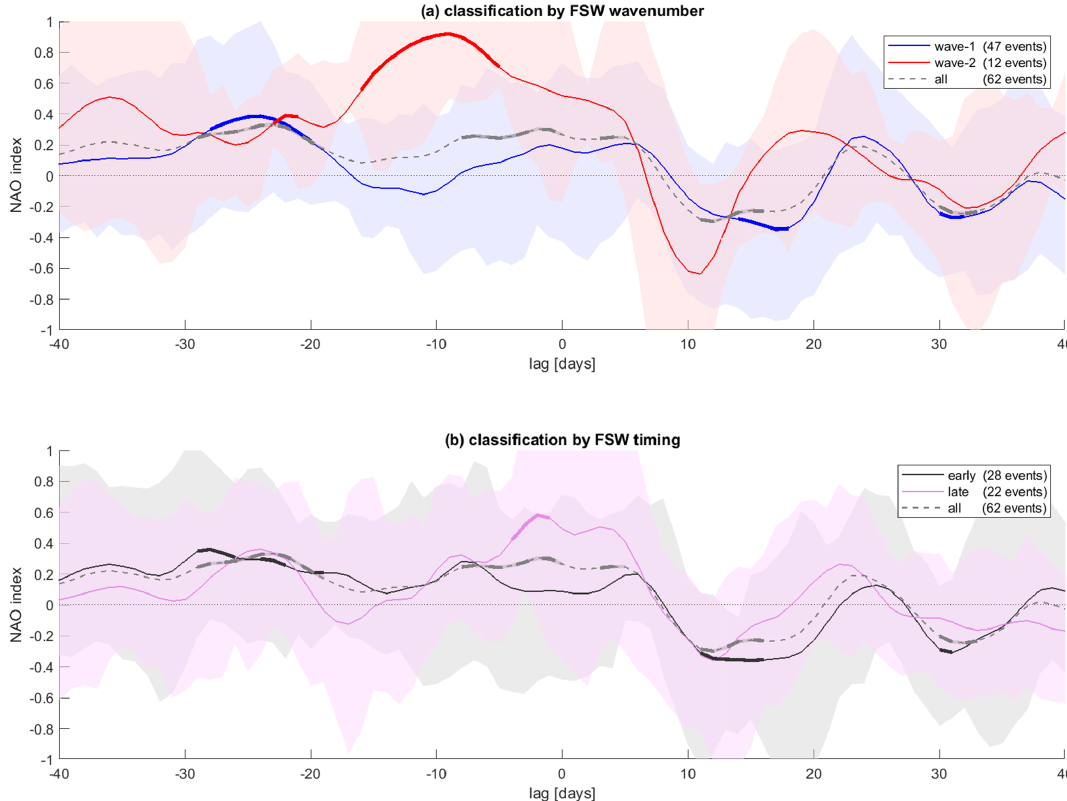
Figure 9. Composite of the NAO index (using a 3d running mean) for lags of − 40 to + 40d around the final warming dates at 50hPa for 1958–2019. (a) The blue (red) lines indicate the average values for the wave-1 (wave-2) classifications, respectively. The dashed gray line is the average over all FSW events from 1958–2019, including unclassified events. Bold parts of the lines indicate values significantly different from zero at the 95% level according to a t test. The blue (red) shading indicates the 25th and 75th percentiles for the wave-1 (wave-2) classification. (b) Same as (a) but for early (black) vs. late (purple) FSW